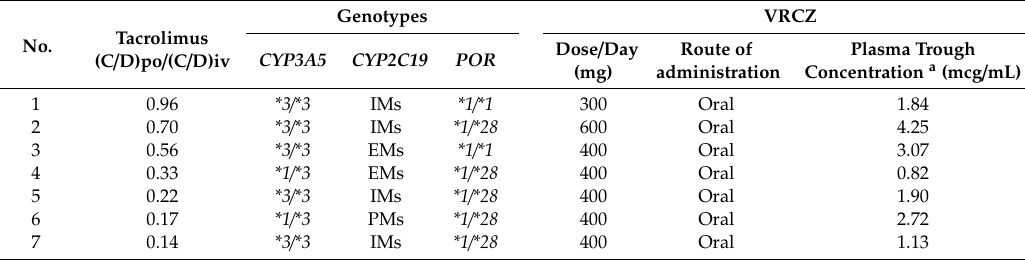
Table 7. Tacrolimus (C / Dpo) / (C / Div) and variables associated with CYP3A5 , CYP2C19 , and POR genotypes in recipients receiving VRCZ ( n = 7).